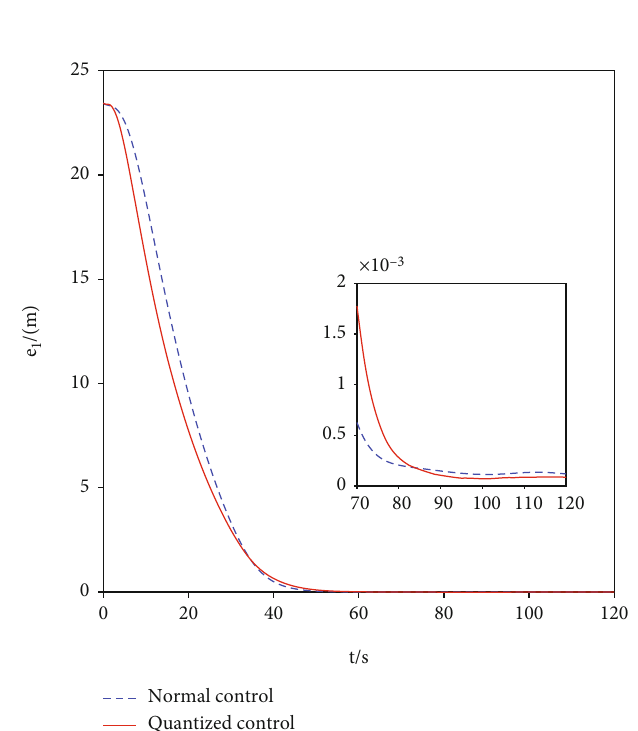
Figure 18: Relative distance error